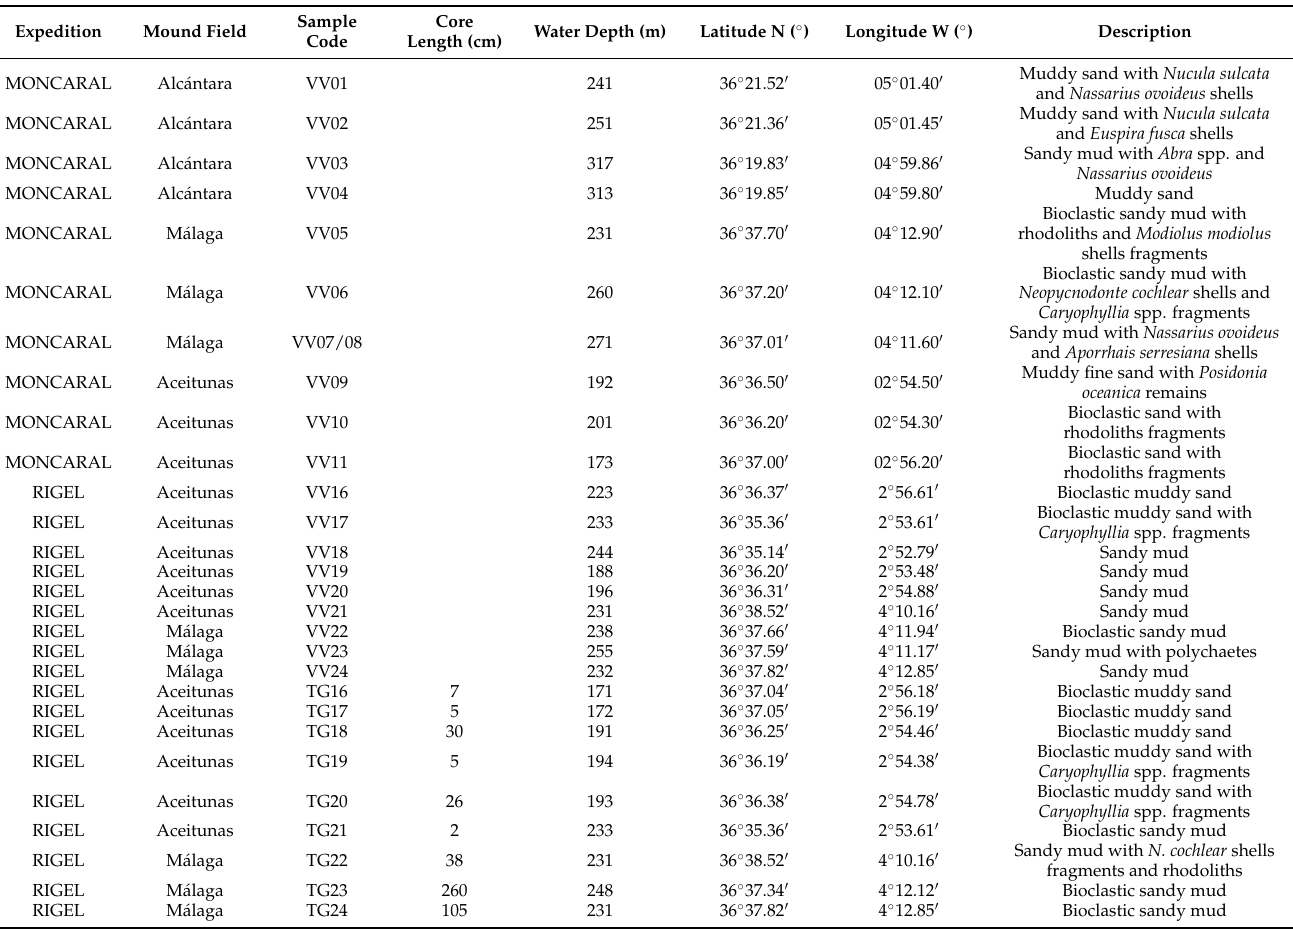
Table A1. Metadata of the surface sediment Van veen grab samples (VV) and gravity cores (TG) recovered during MONCARAL_0516 and RIGEL_1116 expeditions in the northern Alboran